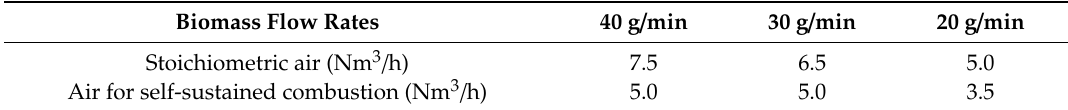
Table 4. Air requirements for the tested mixtures